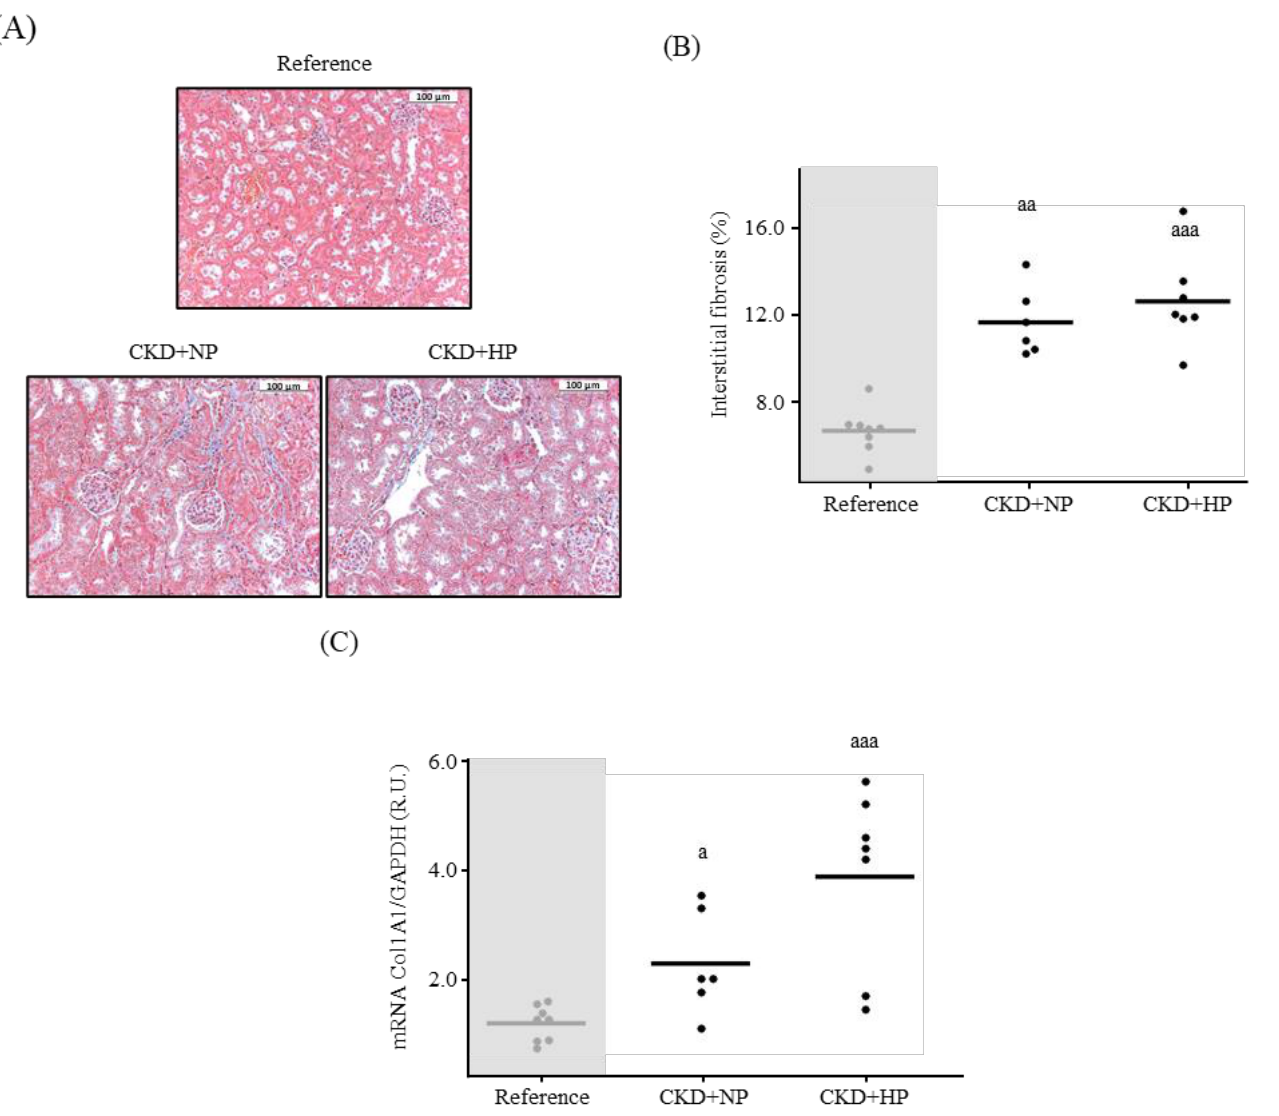
Figure 1. In vivo effects of chronic kidney disease (CKD) and dietary phosphorus intake on kidney fibrosis. ( A ) Representative images for kidney interstitial fibrosis and ( B ) quantification from Sham- operated (Reference) and CKD mice fed a normal phosphorus (NP) or high phosphorus (HP) diet for 14 weeks. Each inset indicates the relative scale in µm. Mean and individual mice values are shown. aa p < 0.01 and aaa p < 0.005 vs. Reference. ( C ) Kidney Collagen 1 mRNA levels. All values are expressed relative to Reference group. Mean and individual mice values are shown. a p < 0.05 and aaa p < 0.005 vs. Reference. R.U., relative units vs. Sham+NP. GAPDH was used as housekeeping gene.